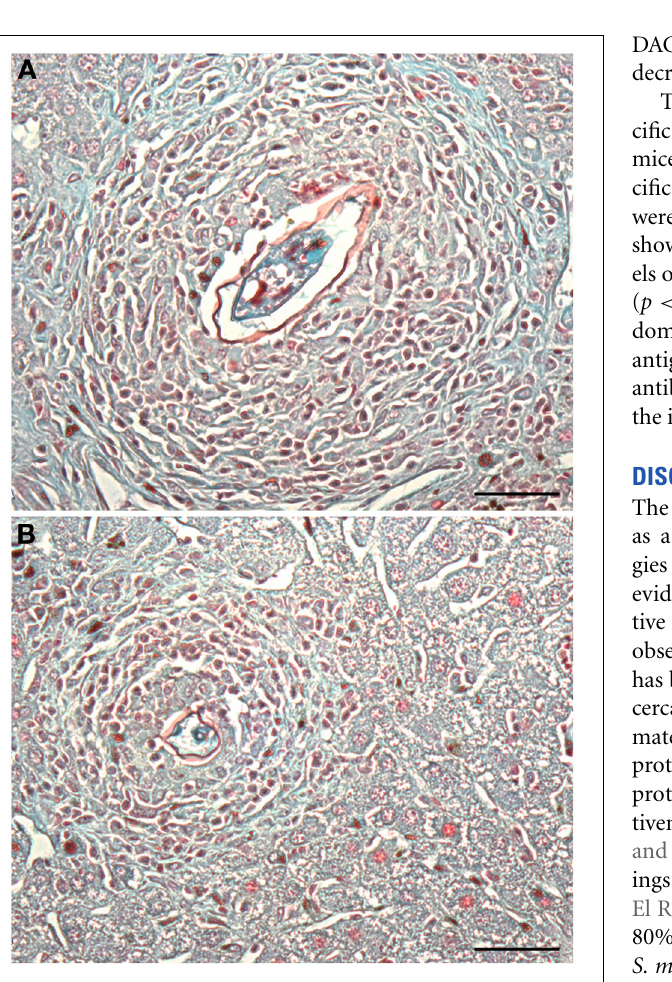
FIGURE 6 | Histological analysis of liver tissue from mice immunized with rSMYB1. Animals were sacrificed 45 days post-infection and their livers were washed with PBS and stored in formaldehyde until histological procedures. Fixed livers were sliced using microtome (4 μ m) and stained with Gomory’s trichromic. (A) Liver from the control group and (B) liver from rSMYB1 immunized mice. Scale bar: 50 μ m. The granulomas were counted in Axiolab Carl Zeiss microscopy using 10 × objective